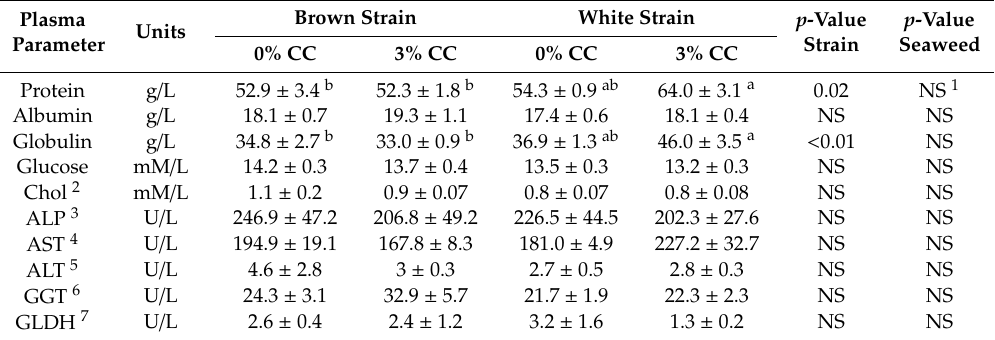
Table 3. Genetic strain and seaweed e ff ects on the plasma chemistry (least squares means ± standard error) in the short-term